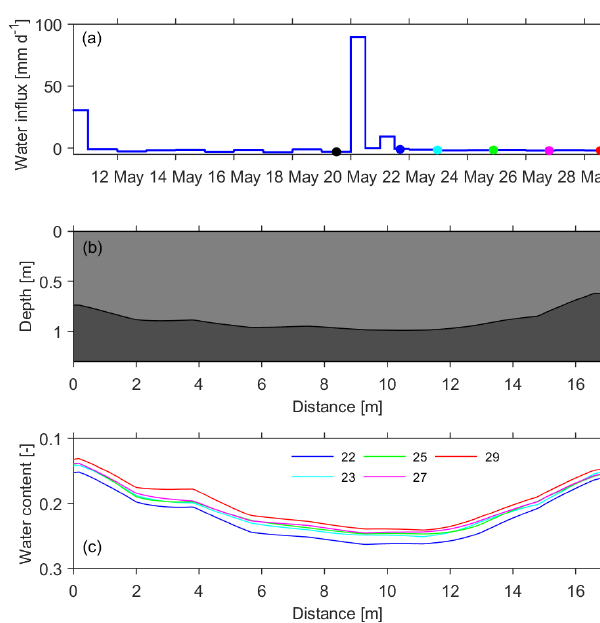
Figure 3. Setup for the inverse modeling. (a) Observed water flux through the upper boundary. The colored dots (excluding the black one) correspond to the timing of soil water storage observations in (c) . (b) The soil architecture of the transect. (c) Mean soil wa- ter content of the upper layer from time-lapse GPR observations on 22, 23, 25, 27 and 29